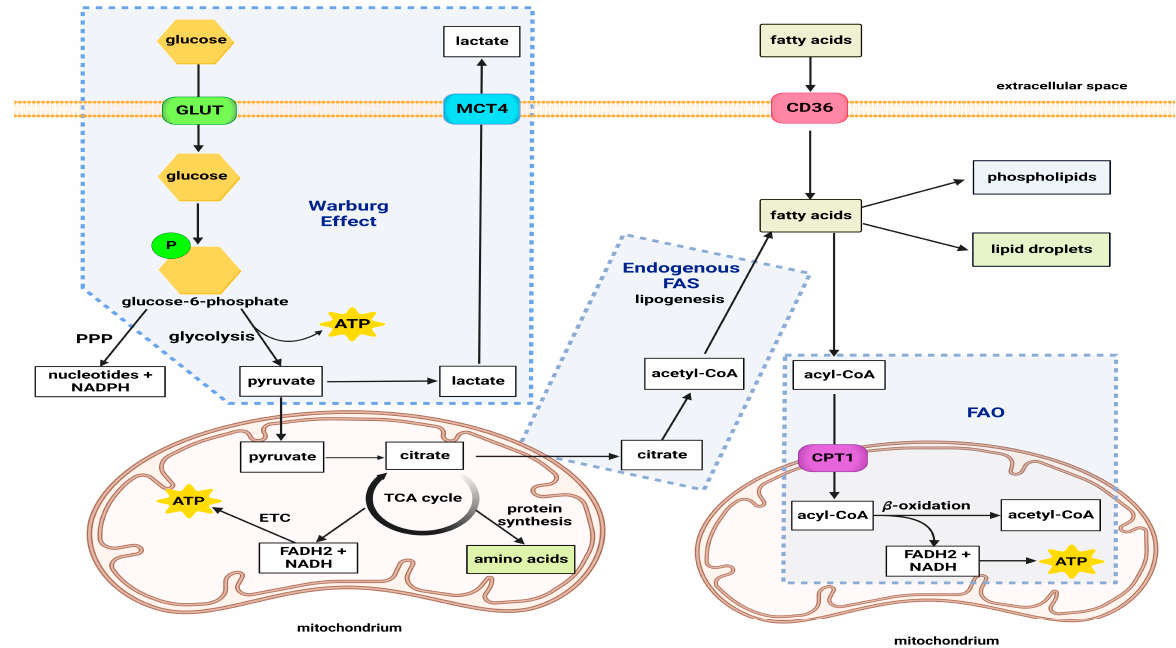
Figure 9. Schematic representation highlighting the metabolic pathways upregulated in cancer. In tumour cells, the uptake of glucose and aerobic glycolysis (the Warburg effect) are upregulated for rapid ATP production. The abundance of lactate that is produced is excreted into the extracellular space/tumour microenvironment. Some pyruvate is shunted into the mitochondrion for OXPHOS. The excess glucose feeds into biosynthesis, such as nucleotide, protein, and lipid synthesis, which supports uncontrolled proliferation. Altered glucose metabolism is linked to altered lipid metabolism in tumour cells, as glucose is the major substrate for lipid synthesis. Both endogenous fatty acid synthesis and fatty acid uptake are upregulated in tumour cells. The fatty acids can be subsequently used for ATP production through β -oxidation, which is also upregulated in tumour cells and supports uncontrolled growth and proliferation. ATP, adenosine triphosphate; CPT1, carnitine palmitoyl transferase 1; ETC, electron transport chain; FAO, fatty acid oxidation; FAS, fatty acid synthesis; GLUT, glucose transporter; MCT4, monocarboxylate transporter 4; PPP, pentose phosphate pathway; TCA cycle, tricarboxylic acid